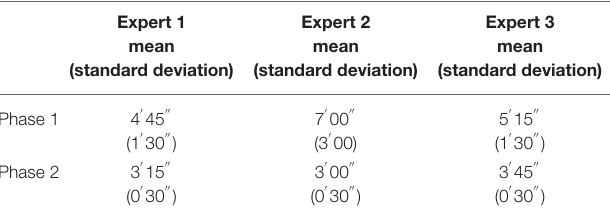
TABLE 9 | Mean (standard deviation) time elapsed to perform radiological readings of the patients of interest for each of the three experts and each of two phases of the second